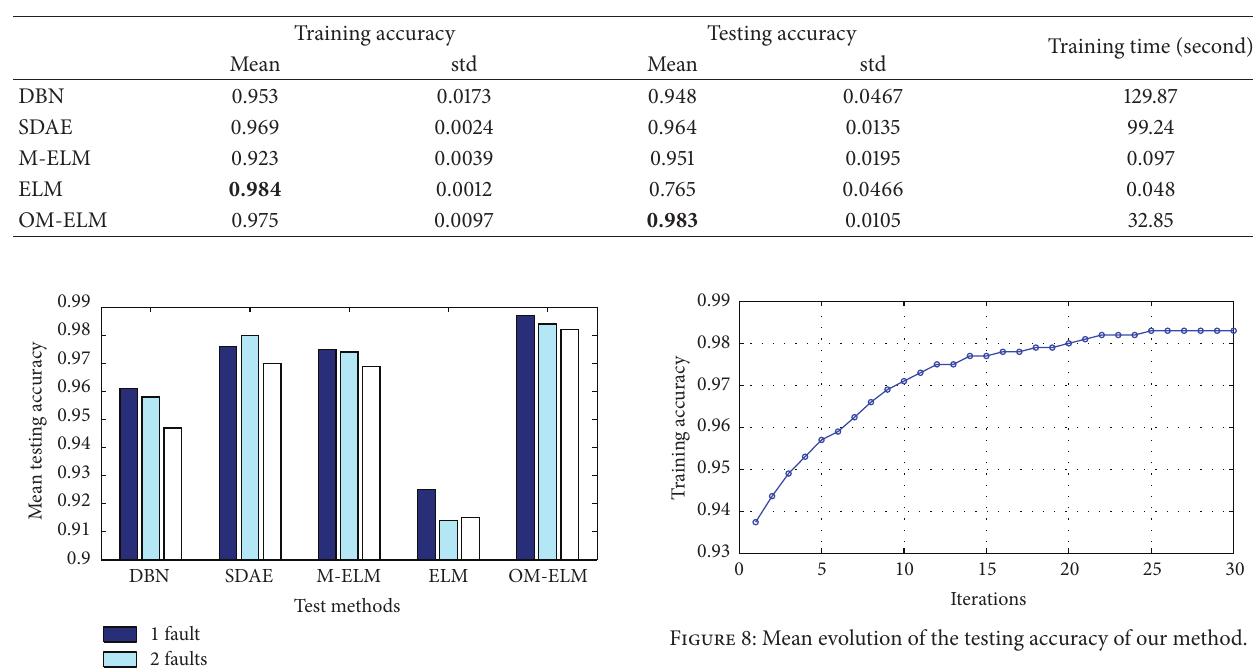
Table 6: Performance of all methods on data set with noise level 𝑁 𝑙 = 0.1 .